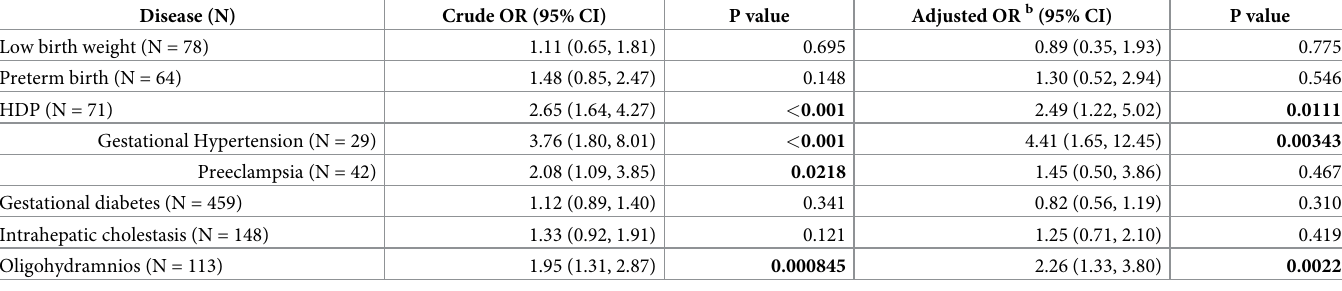
Table 3. Relationship between fetal fraction (Fetal fraction < 25th percentile vs. fetal fraction � 25th percentile a ) and pregnancy-related complications. Disease